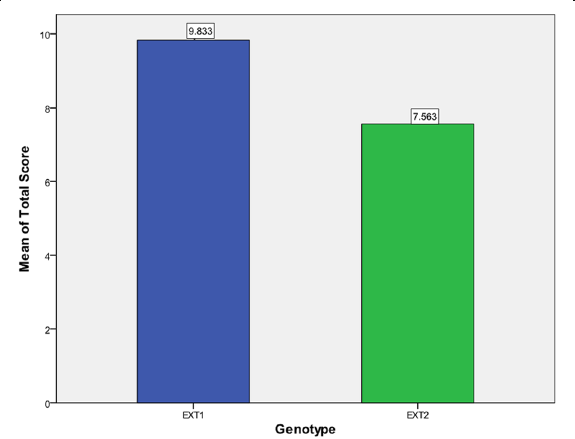
Fig. 3 Total score of different EXT genotypes. The mean total score of patients with EXT1 mutations was 9.83, higher than that of patients with EXT2 mutations. ( p = 0.001, t-